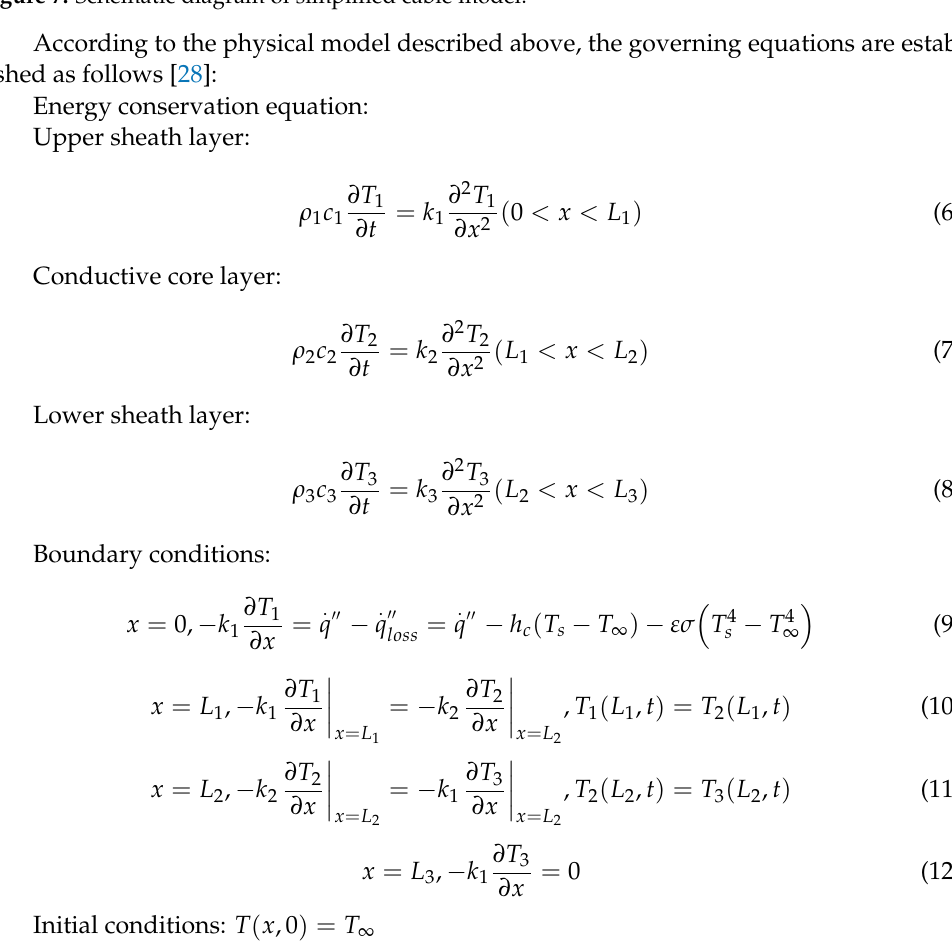
Figure 7. Schematic diagram of simplified cable model.